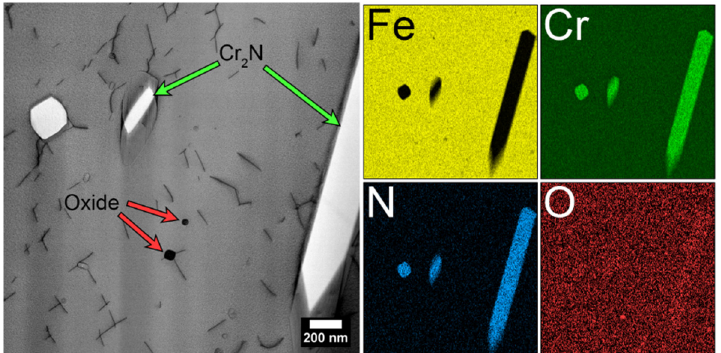
Figure 8. TEM of the annealed SS446 ferritic stainless-steel, showing a BF STEM image and corre- sponding EDS maps for Fe, Cr, N and O. The black lines in the STEM image are likely dislocations in the ferrite.